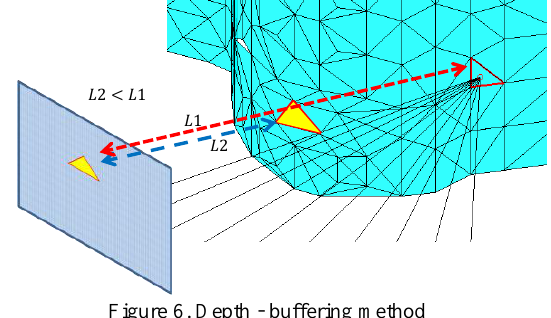
Figure 6. Depth - buffering method